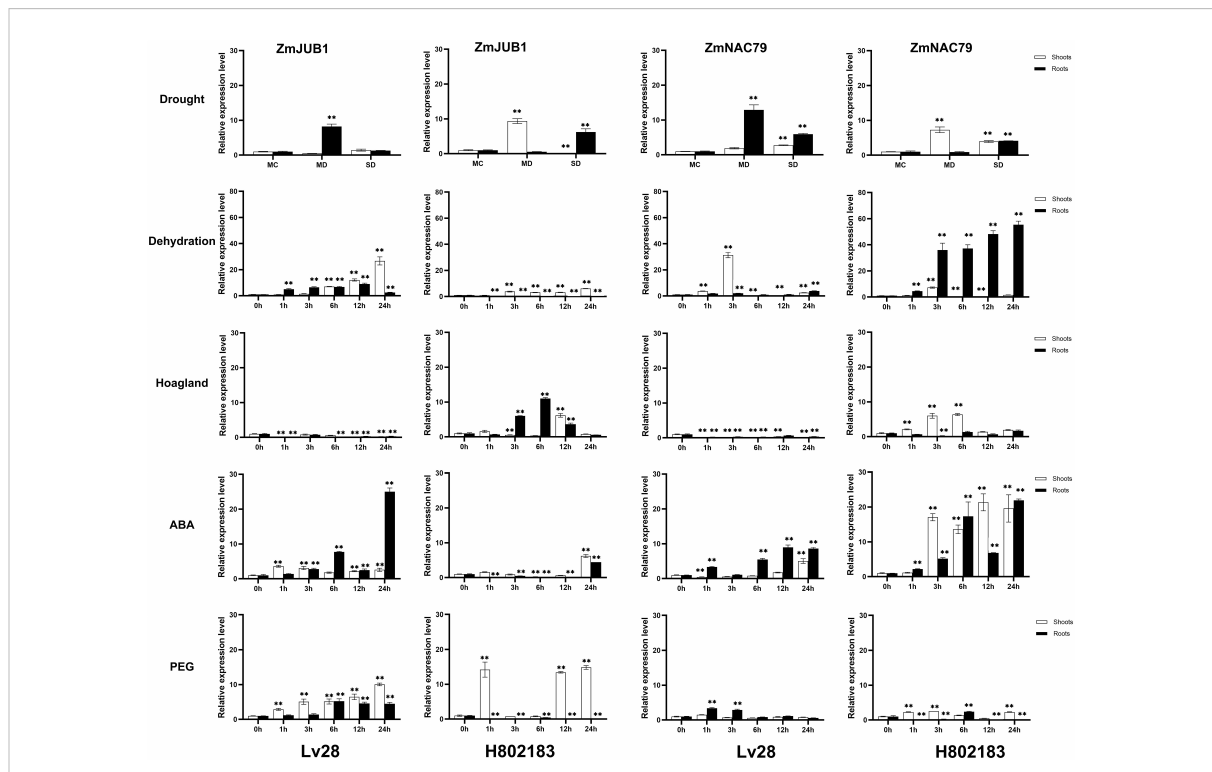
FIGURE 4 Expression analysis of ZmJUB1 and ZmNAC87 under drought stress, dehydration, Hoagland, 100 m M ABA, and 20% PEG treatments in Lv28 and H082183. Maize ZmGAPDH (NM_001111943) was used as the internal reference gene. Highly signi fi cant differences (P < 0.01) were represented by